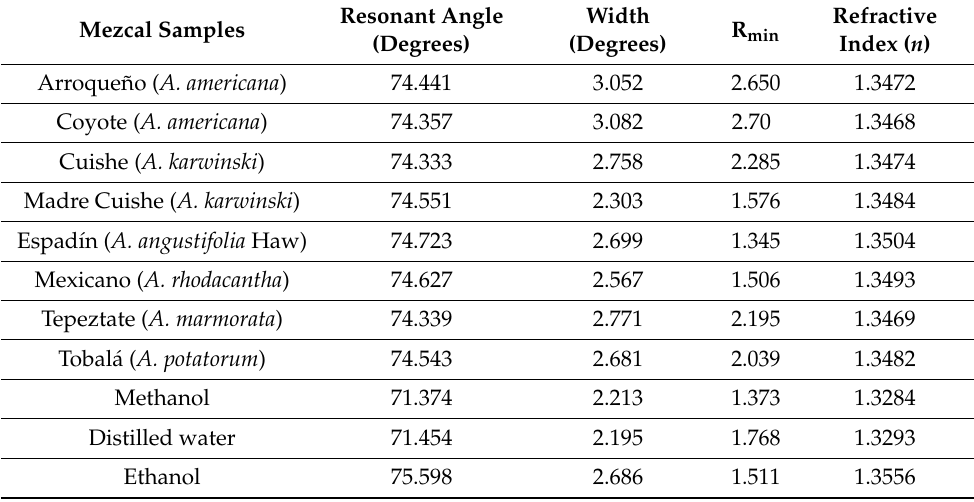
Figure 2. SPR curves at sweep angle of ( a ) eight mezcal samples and ( b ) water, methanol, and ethanol solutions measurements with “mexicano” mezcal sample as reference for pointing to the resonant angles region of the samples. Table 3. SPR curve parameters of mezcal samples and reference